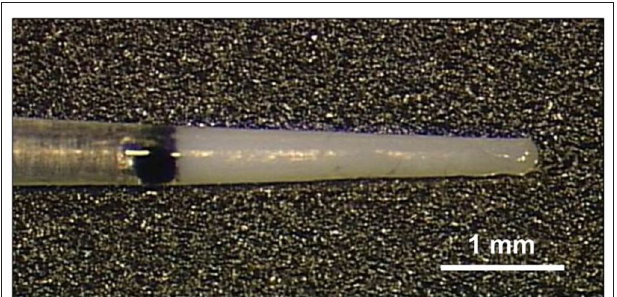
FIGURE 1 | Silicone rod containing 10% (55 µ g) dexamethasone. The drug is incorporated into the first 3mm from the tip. The rod was implanted into the scala tympani. The black dot (colored silicone) indicates the insertion depth of 3mm and was located at the rim of the cochleostomy.